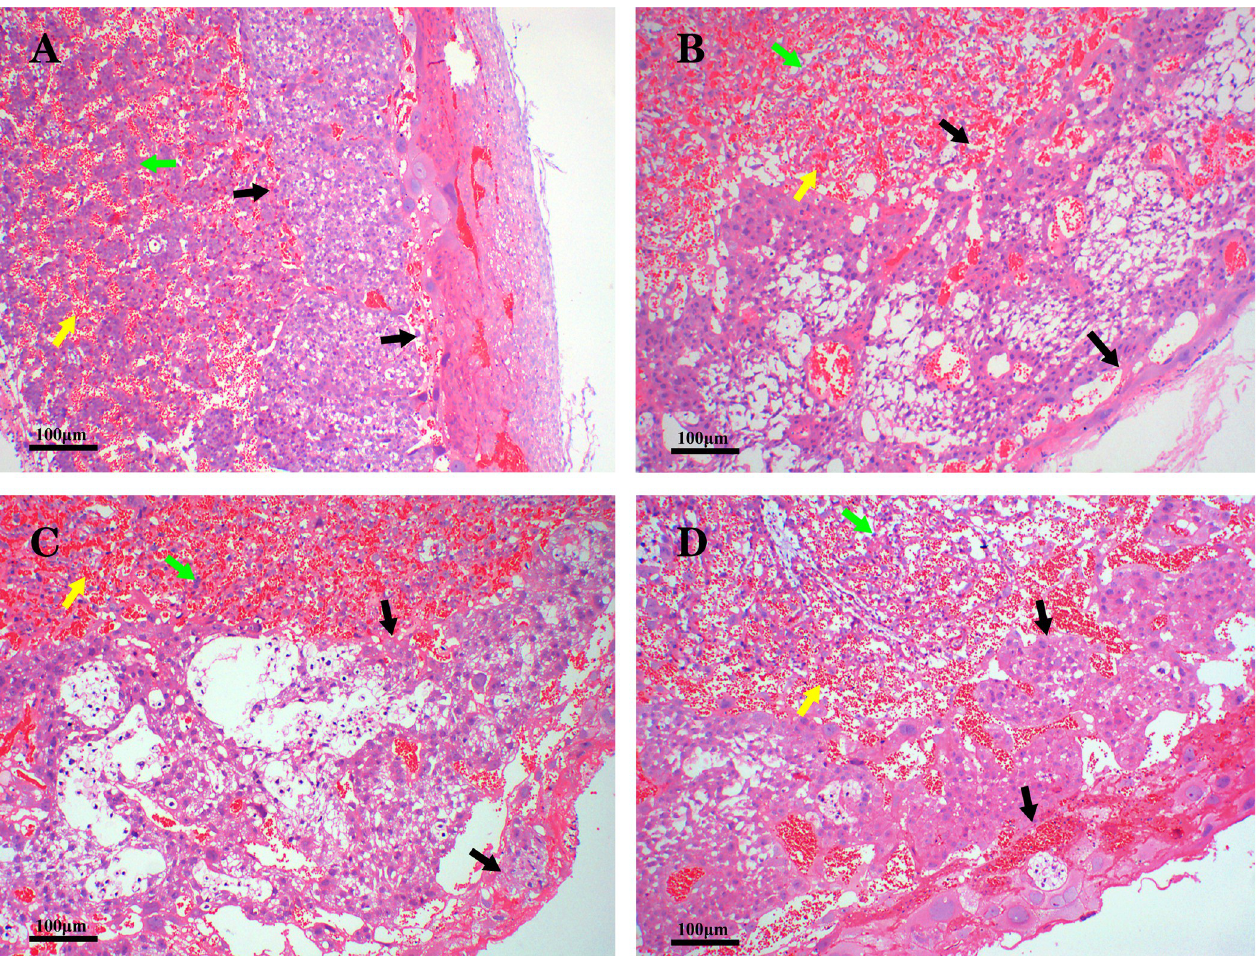
Fig 5. Structural and morphological changes in the placental tissue in the four rat groups. HE-stained placental tissue sections from (A) the NC group, (B) the HFHS group, (C) the HFHS+STZ group, and (D) the HFHS+MR group. Black arrows: placental stratification boundary. Yellow arrows: capillaries. Green arrows: trophoblast cells. Scale bar = 100 μ